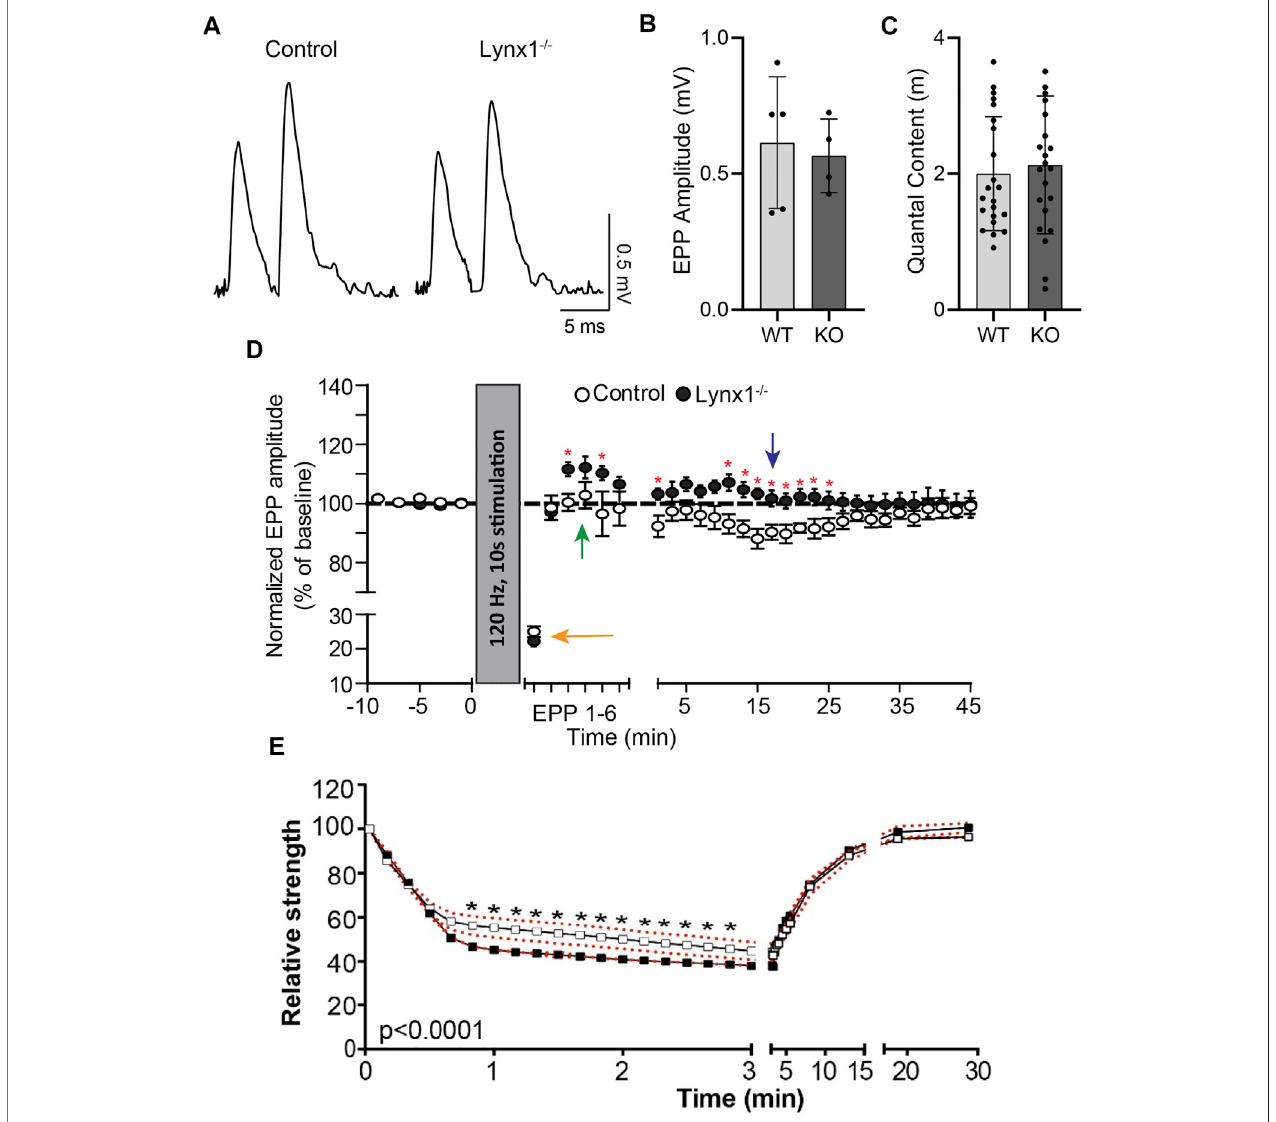
FIGURE4| Lynx1reducessynapticplasticity. (A) Examplerecordingsofendplatepotentials(EPPs)elicitedbypaired-pulsestimulation(0.2Hz,10-minterval)from control and Lynx1 − / − extensor digitorum longus (EDL). (B) The average EPP amplitude (measured of the fi rst EPP of the pair) and (C) the average quantal content followingpaired-pulse stimulation. (D) Theamplitude ofEPPsat baseline andfollowingtetanicstimulation(120Hz,10s). Theorangearrow denotesrapiddepolarization following initial stimulation. The green arrow denotes post-tetanic potentiation in Lynx1 − / − but not control muscle. The blue arrow denotes the absence of long- lastingdepressioninLynx1 − / − muscle. (E) Neuromuscularfatiguerepresentedasrelativestrength,asapercentofbaseline,followingsuper-imposedmusclestimulations after fatigue protocol in 4-month-old control and Lynx1 − / − EDL (red dotted line represents SEM). Values in (B) and (C) are mean ± SD, and values in (D) and (E) are mean ± SEM. * p < 0.05, unpaired, two-tailed Student ’ s t -test.